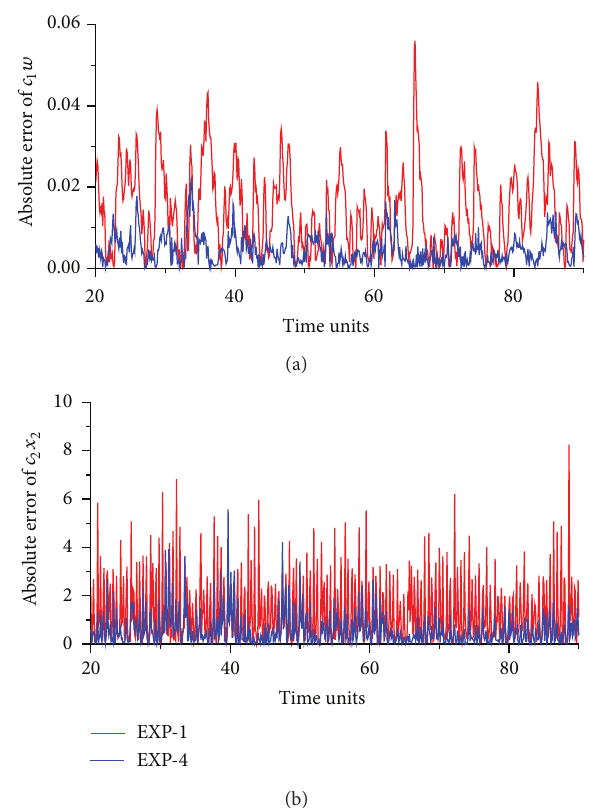
Figure 6: Time series (20–90 TUs) of the absolute errors of (a) 𝑐 1 𝑤 and (b) 𝑐 2 𝑥 2 in the 4D-Var CPE with the observational interval and the minimization time window being 10 and 500 time steps. Here, the red and blue curves represent the results in EXP-1 and EXP-4,